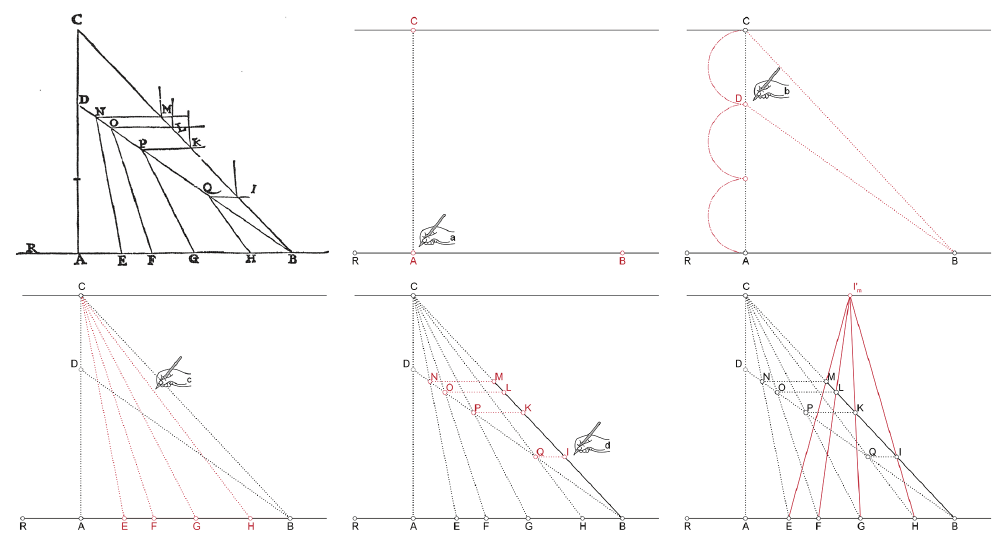
Figure 9 Illustration of the perspective construction with the second false rule described by Danti. Author’s